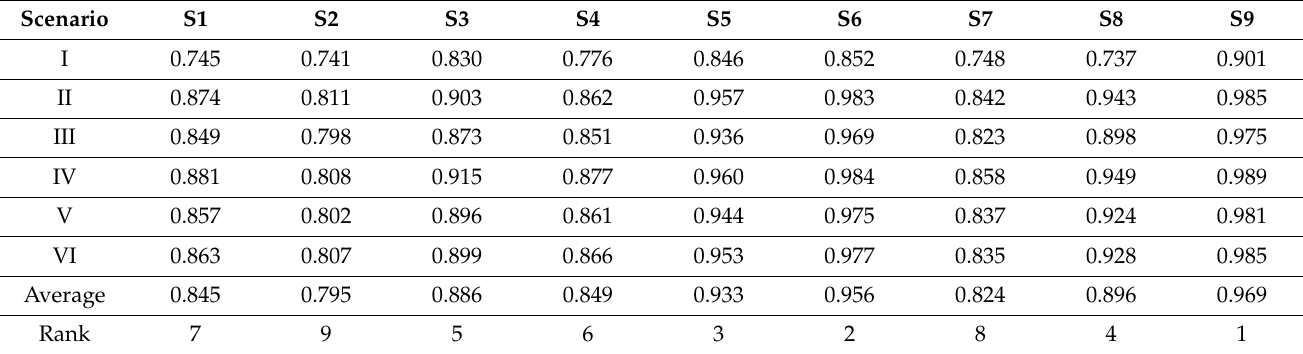
Figure 8. Variable Importance Plot from Random Forest. Table 5. Comparison of Classification Accuracy by Tree Species using Random